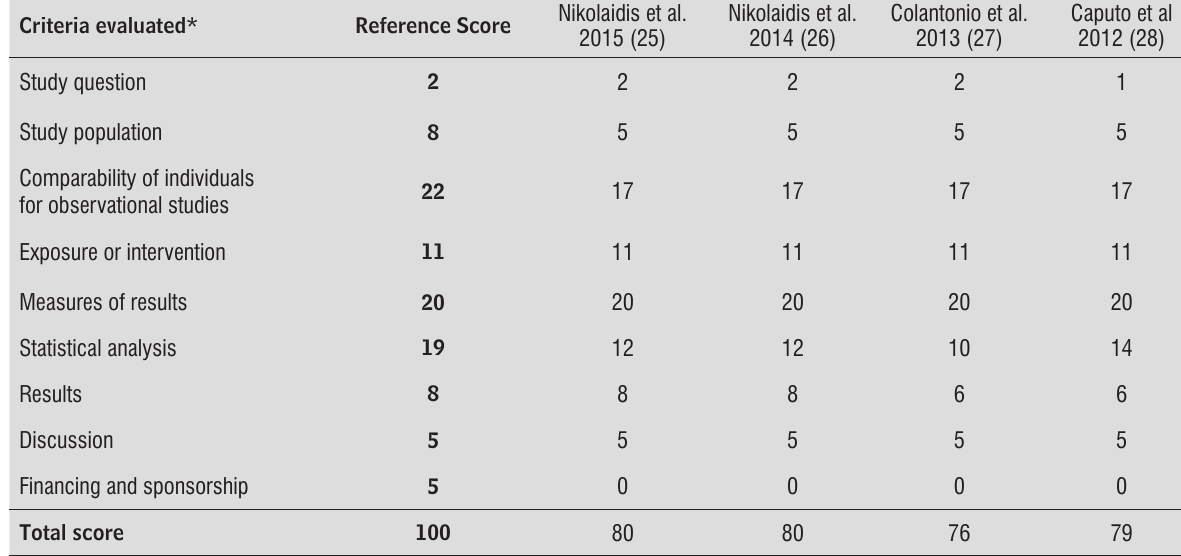
Table 3 - Evaluation of the methodological quality of the studies included in this systematic review. Criteria